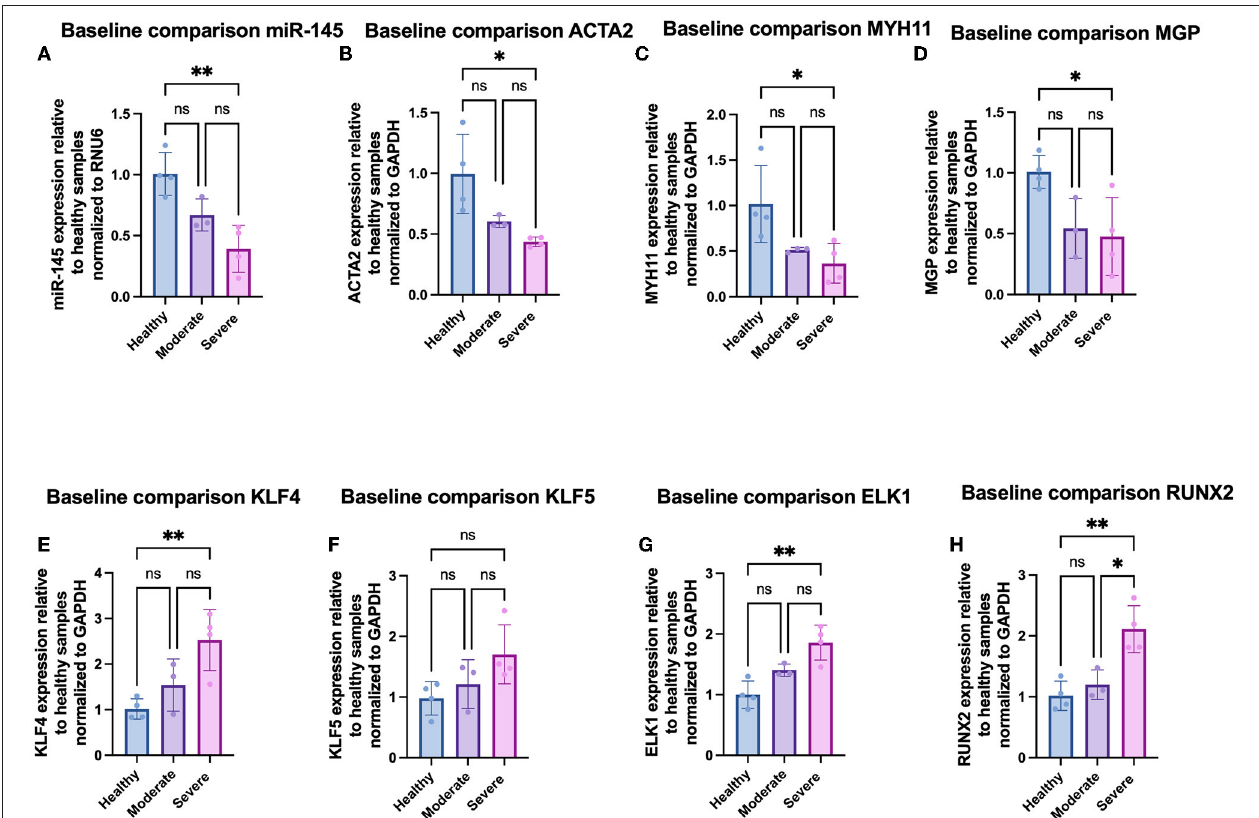
FIGURE 3 | Gene expression of (A) miR-145, (B) ACTA2, (C) MYH11, (D) MGP, (E) KLF4, (F) KLF5, (G) ELK1, and (H) RUNX2 in VSMCs derived from varying disease severity. * p < 0.05, ** p < 0.01.